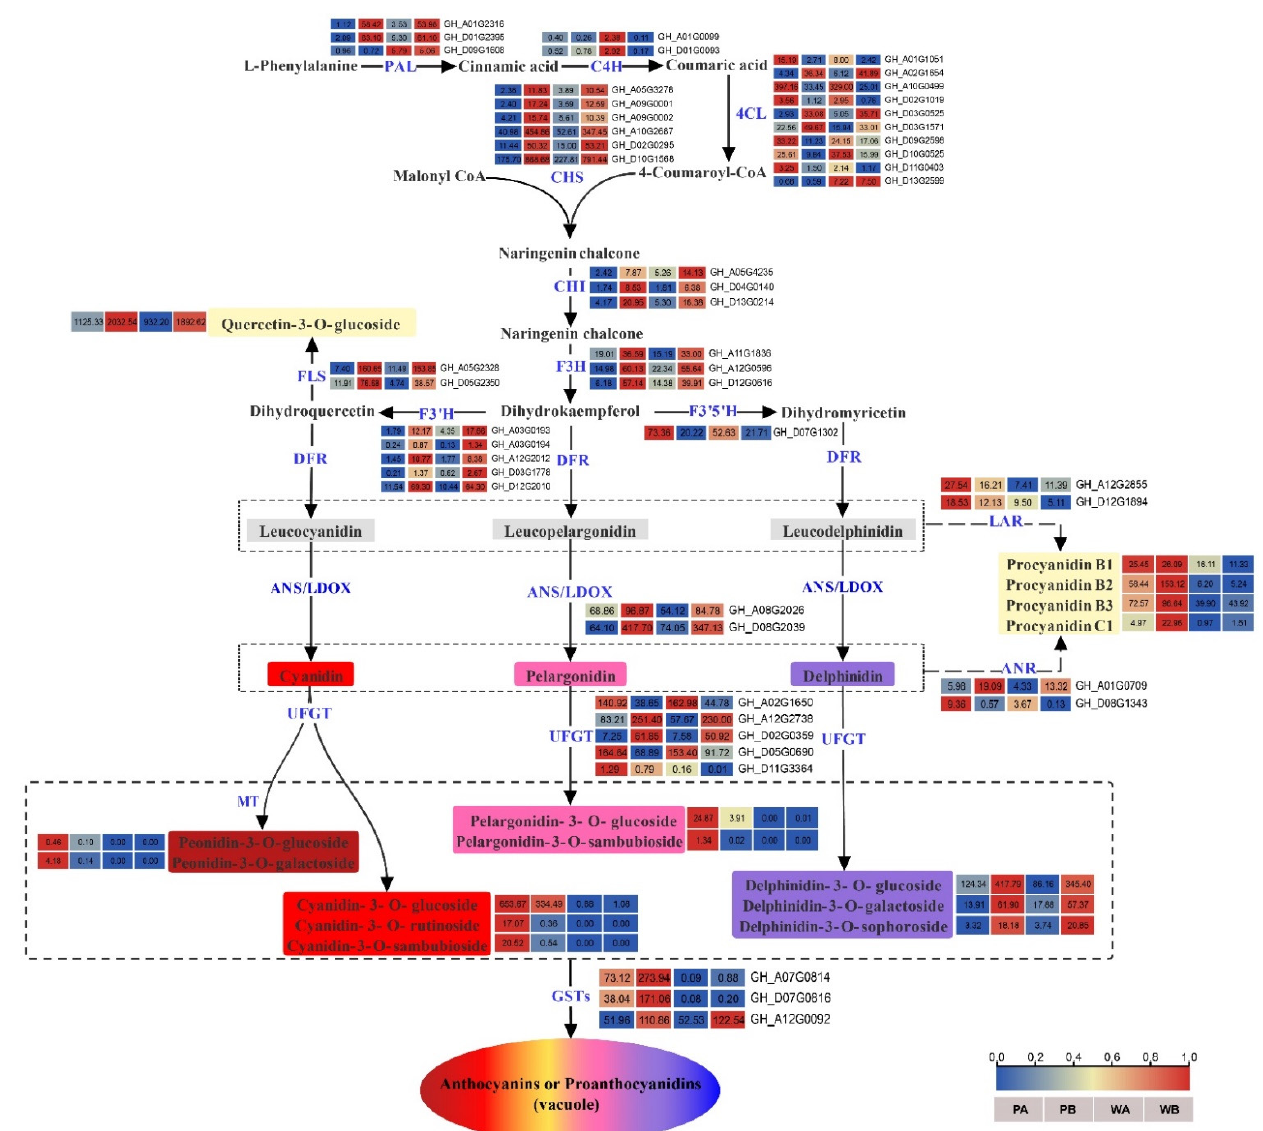
Figure 6. The pathway related to anthocyanin biosynthesis and the heat map of changes in metabolites and transcripts in anthocyanin metabolisms. The expression levels of Phenylalanine ammonia lyase (PAL), Cinnamate 4-hydroxylase (C4H), and 4-coumarin: Co-A ligase (4CL), Chalcone synthase (CHS), Chalcone isomerase (CHI), Flavanone 3-hydroxylase (F3H), Flavonoid 3 ′ -hydroxylase (F3 ′ H), Flavonoid 3 ′ ,5 ′ -hydroxylase (F3 ′ 5 ′ H), Dihydroflavonol 4-reductase (DFR), Anthocyanidin synthase (ANS), Leucoanthocyanidin reductase (LAR), Anthocyanidin reductase (ANR), Flavonoid 3-O-glucosyltransferase (UFGT), Glutathione S-transferase (GST), and anthocyanin metabolites are shown.